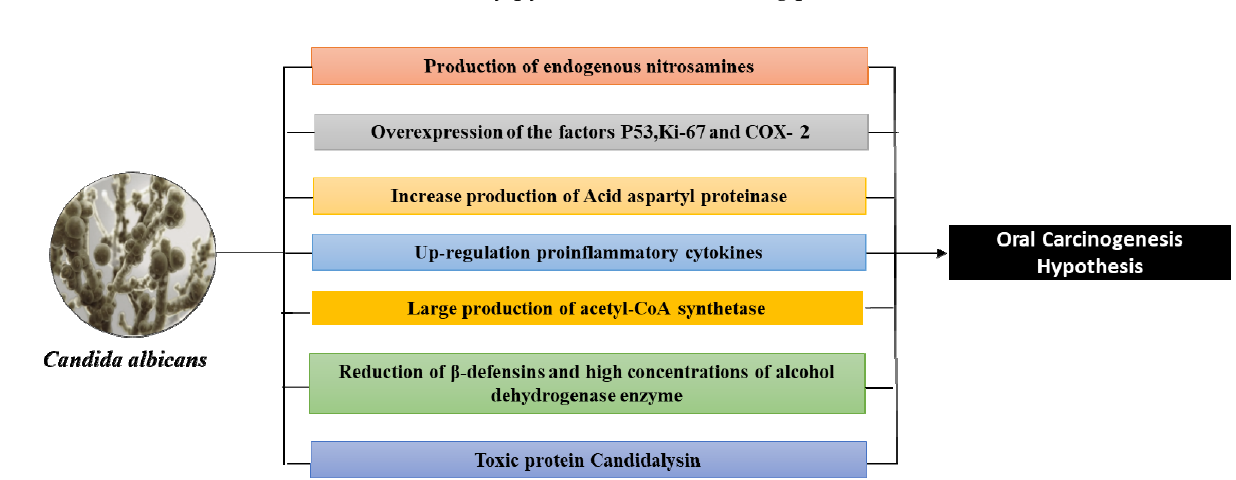
Figure 2. The main hypothetical molecular mechanisms by which C. albicans can cause precancerous and malignant neoformations in the oral cavity.